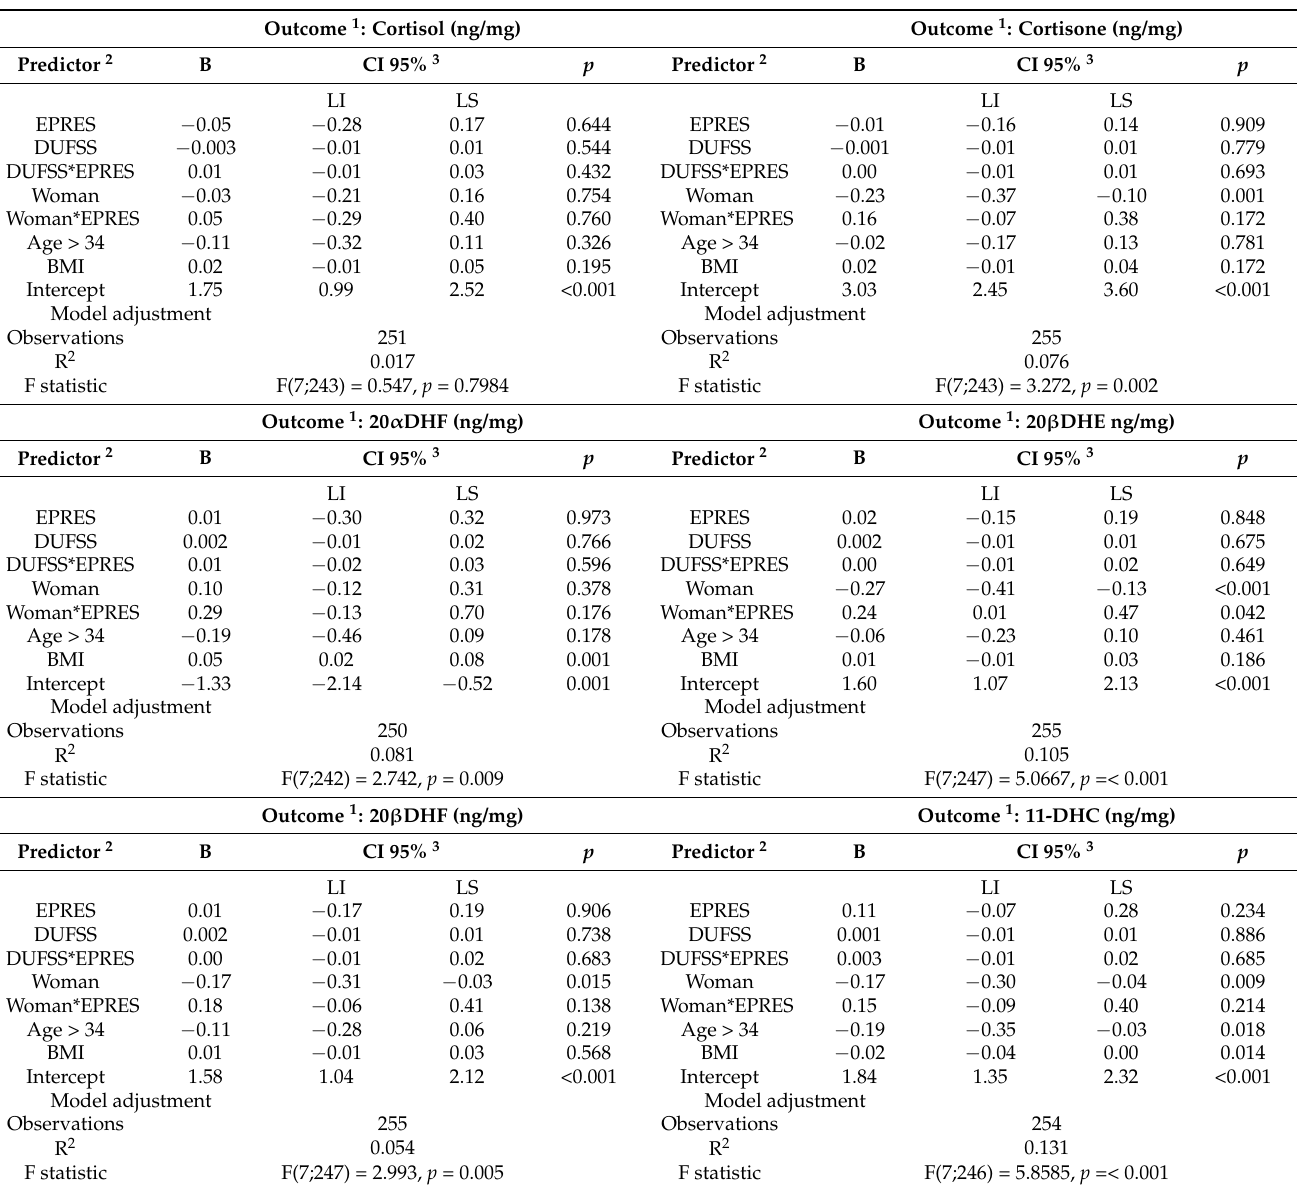
Table 3. Regression results of social support and employment precariousness interaction model predicting different biomarker